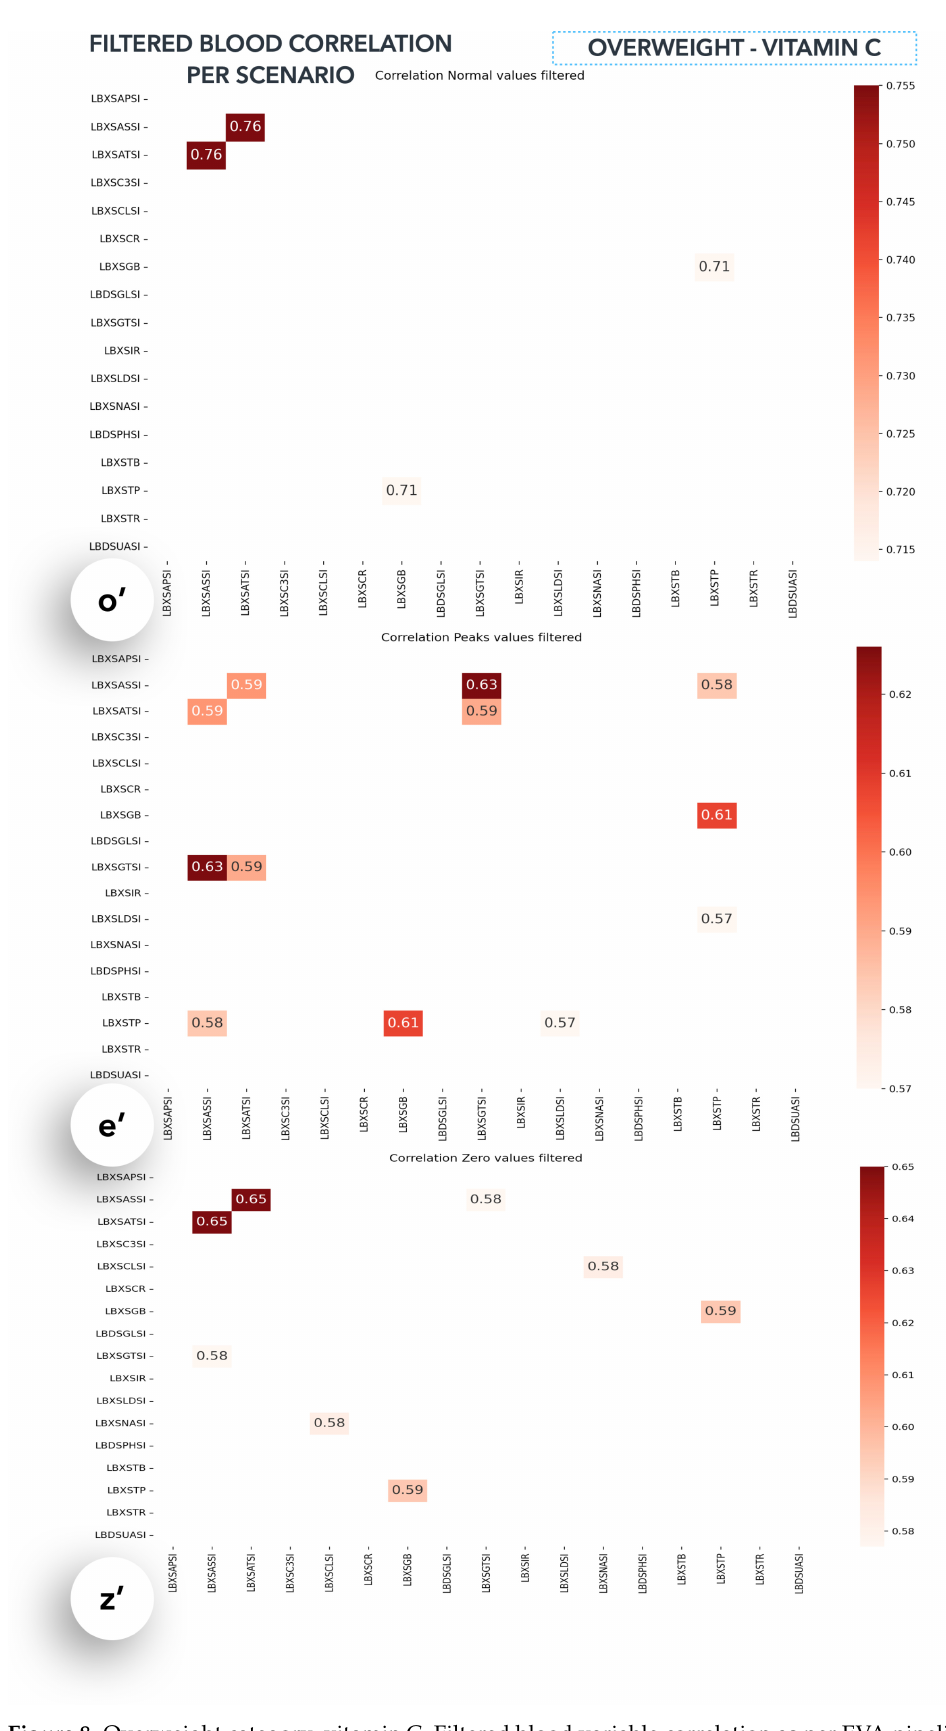
Figure 8. Overweight category–vitamin C. Filtered blood variable correlation as per EVA